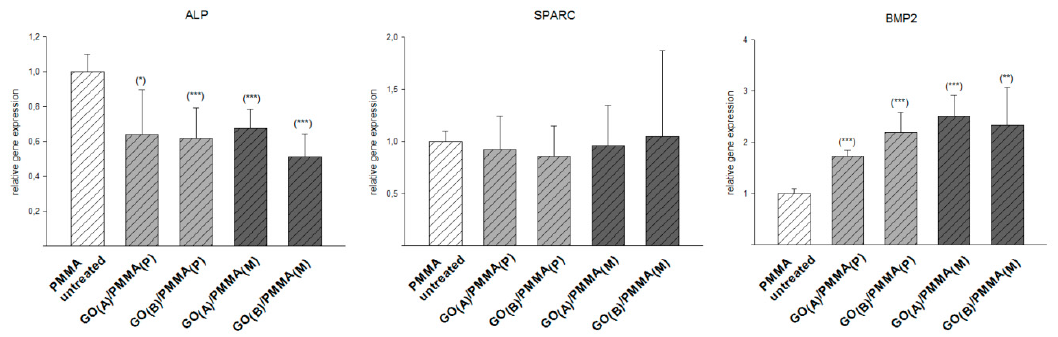
Figure 5. The expression of specific osteogenic markers (ALP, SPARC, and BMP-2) of hMSPCs cultured in the absence of a specific induction medium for 21 days on the surface of GO/PMMA composites as well as untreated PMMA; p < 0.001 ***; p < 0.01 **; p < 0.05 *.